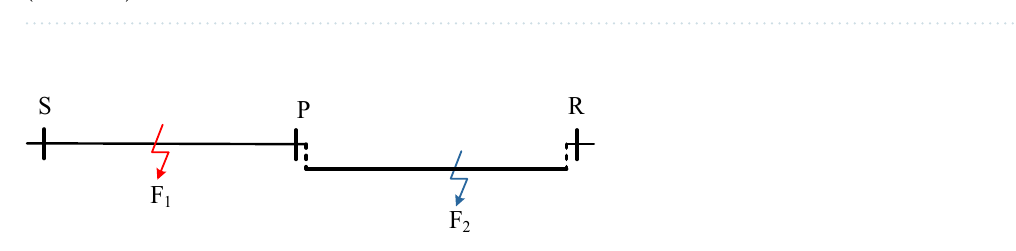
Table 6. Traveling wave energy attenuation coefficient for cable lines with different propagation distances (scenario 2).